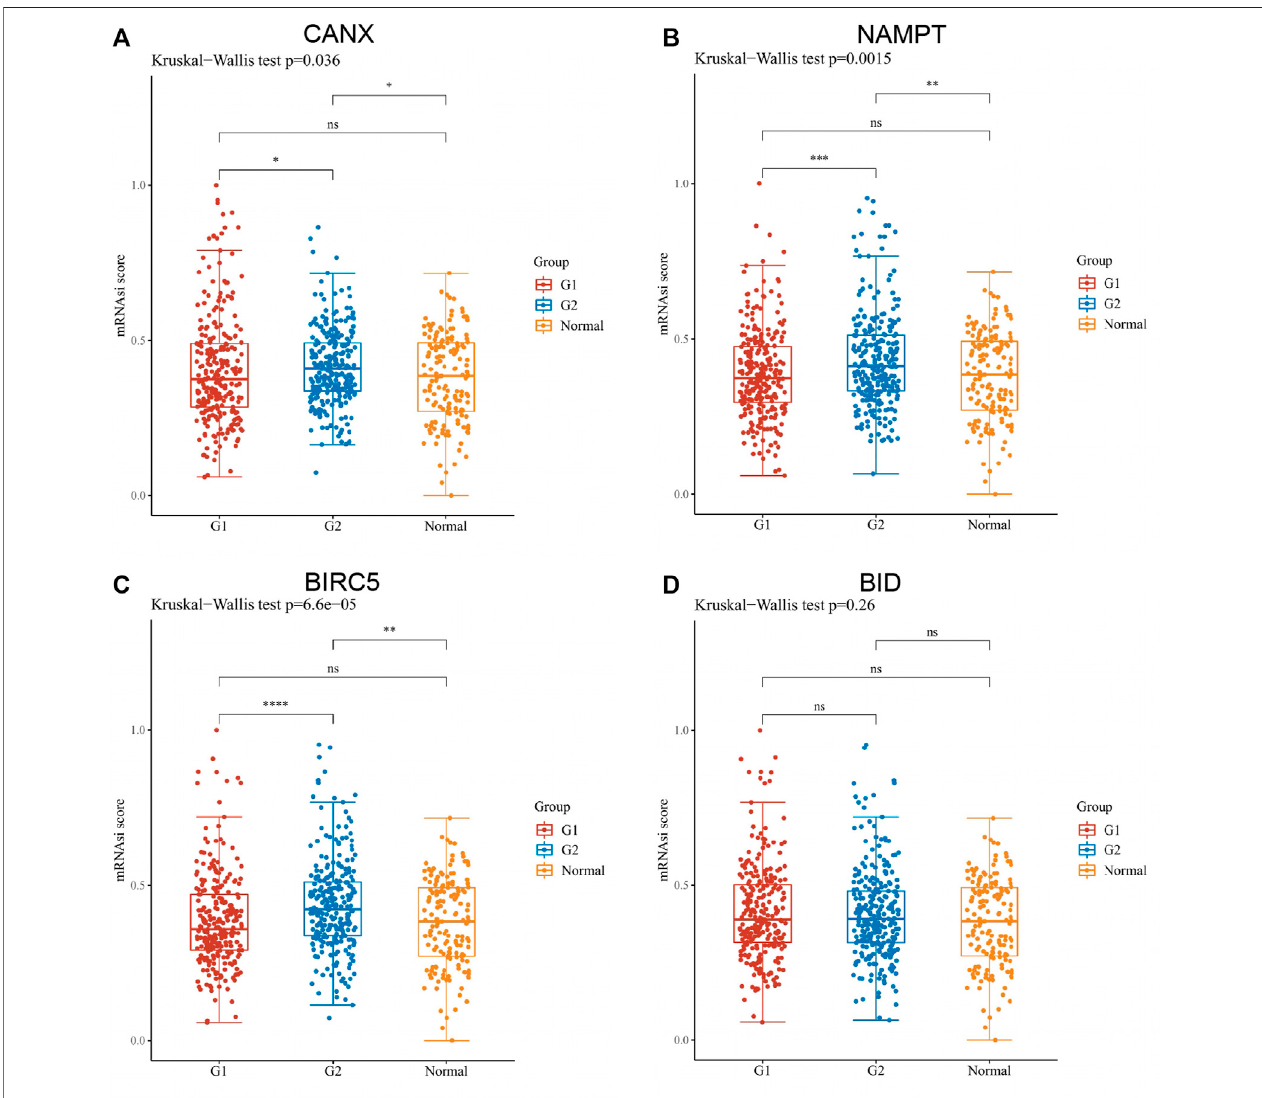
FIGURE 11 | Assessment of the one-class logistic regression (OCLR) scores of immune-autophagy-related differentially expressed genes (DEGs) in kidney renal clearcellcarcinoma(KIRC).ScatterdiagramillustratingtherelationshipbetweenCANX (A) ,NAMPT (B) ,BIRC5 (C) ,andBID (D) andOCLRscoreinKIRC.Thehorizontal axis in the fi gure represents the gene expression distribution, and the vertical axis is the OCLR score distribution. G1 is a low-expression group, and G2 is a high- expression group.